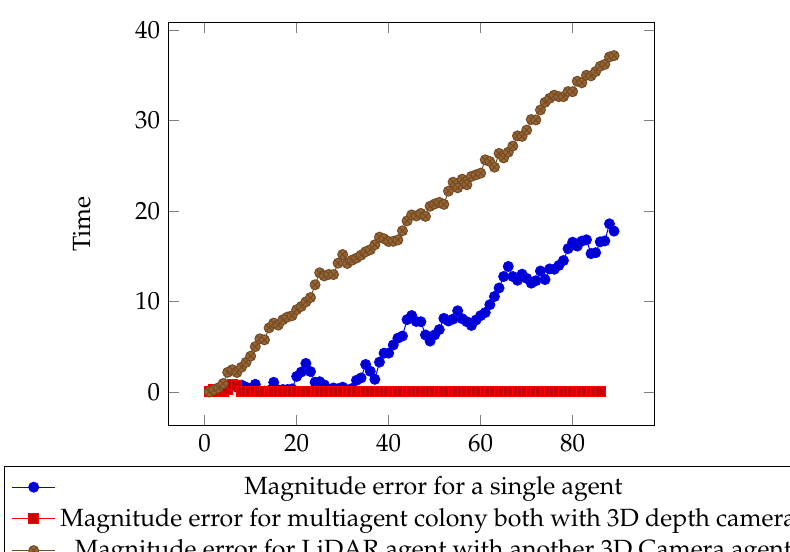
Figure 29. Data showing error over time.